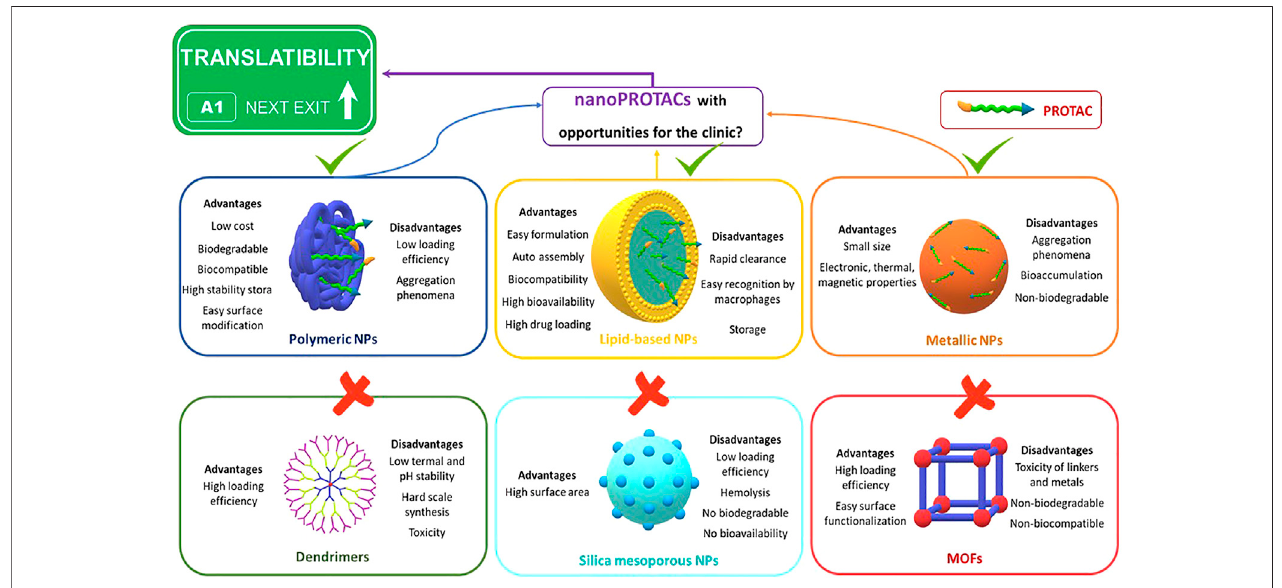
FIGURE 3 | Advantages and disadvantages of different drug delivery systems for the rapid translatability of nanoPROTACs. MOFs and silica mesoporous NPs are not biodegradable and biocompatible, dendrimers are mainly toxic and dif fi cult to scale their synthesis, metallic NPs are easily accumulated in the body and cause aggregationphenomena,lipid-basedNPsreachhighdrugloading,buttheirhalf-lifeinbloodmightlimittheirclinicalimplementation,polymericNPsarethemostpotential candidates for clinical translation due to their high biocompatibility, and payload and surface modi fi cation fl exibility.